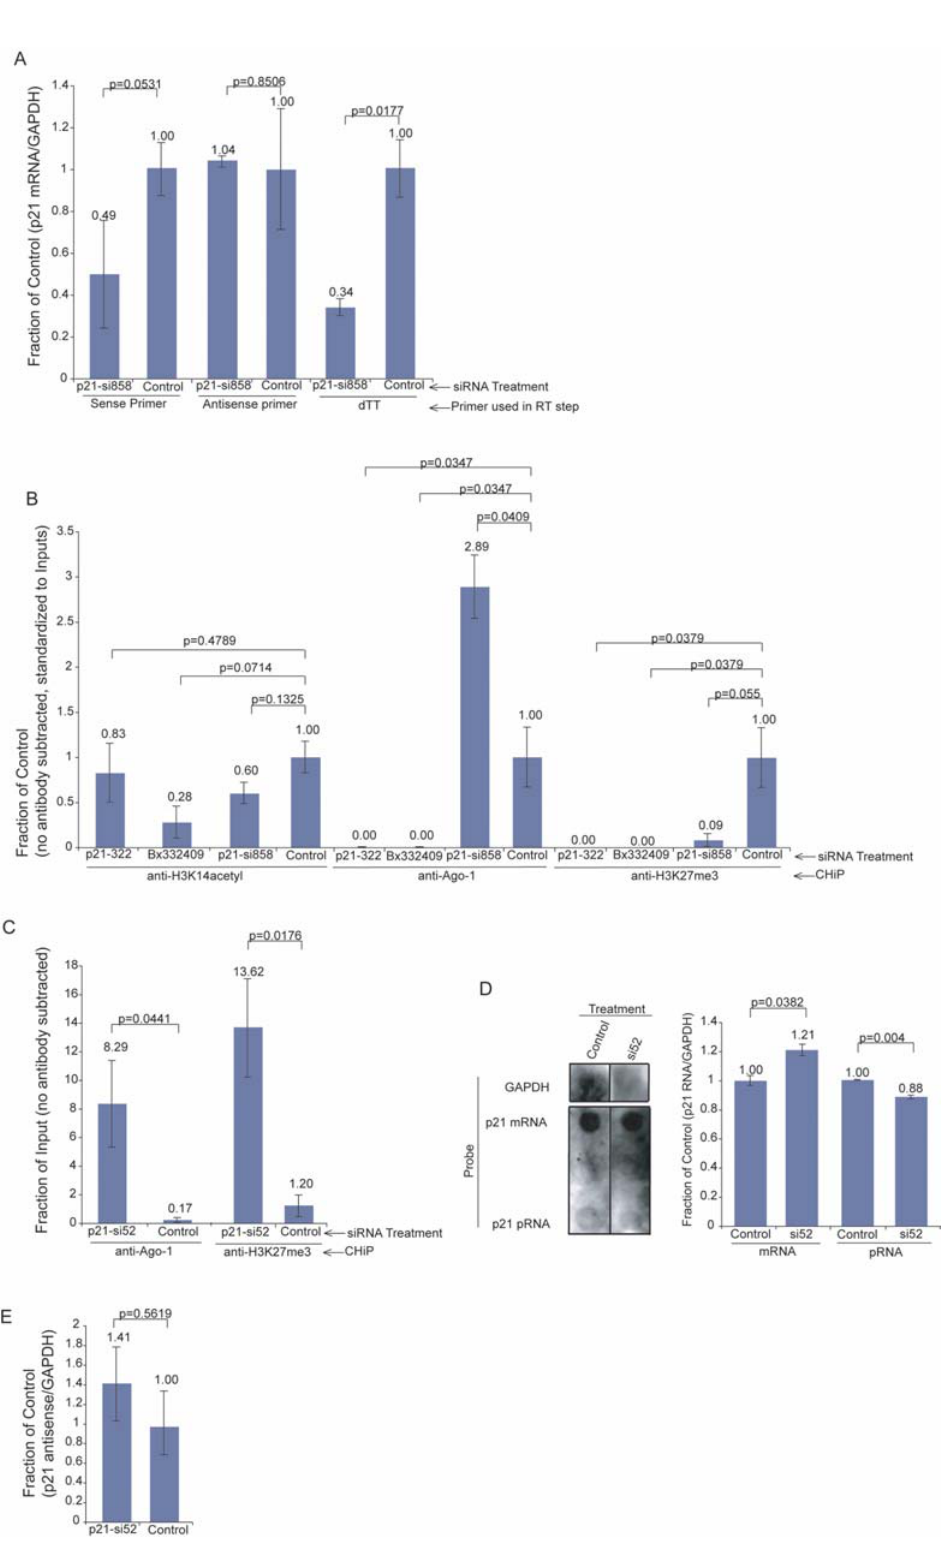
Figure 3. Suppression of p21 sense/mRNA expression results in the recruitment of Ago-1 and H3K27me3 to the p21 promoter. (A) siRNA p21-si858, which is targeted to the p21 sense/mRNA, suppresses p21 sense/mRNA transcription with no effect on p21 antisense transcription. Results from triplicate transfected MCF-7 cell cultures are shown with the standard deviations and p values from paired T tests. (B) The suppression of p21 sense transcription results in an increase, 24 hrs post-siRNA transfection, in Ago-1 at the p21 promoter whereas suppression of the p21 antisense transcript results in a loss of Ago-1 enrichment at the p21 promoter. Triplicate measurements from a single ChIP assay are shown with the standard deviations and p values from paired T tests. (C) The suppression of p21 sense transcription results in an enrichment of Ago-1 and silent state epigenetic marks H3K27me3, specifically at the p21 promoter 48 hrs post-siRNA treatment. The averages with the standard error of the means are